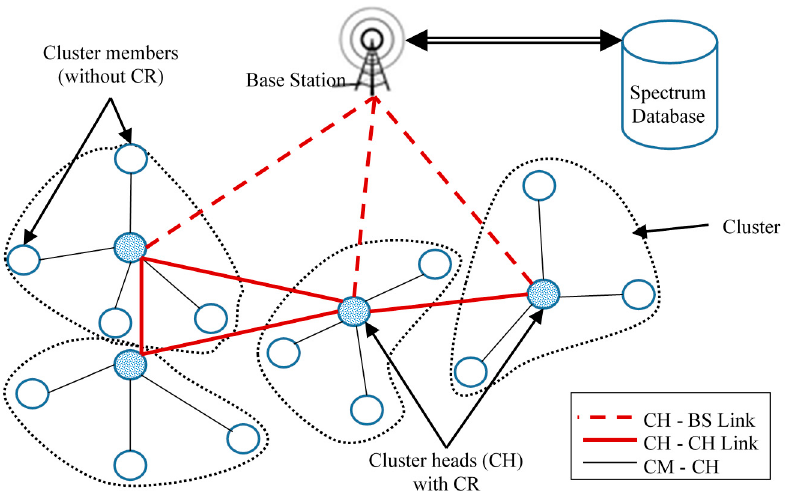
Figure 4. Hierarchical network topology for a CR-WSN where only the CHs are CR-WS nodes.